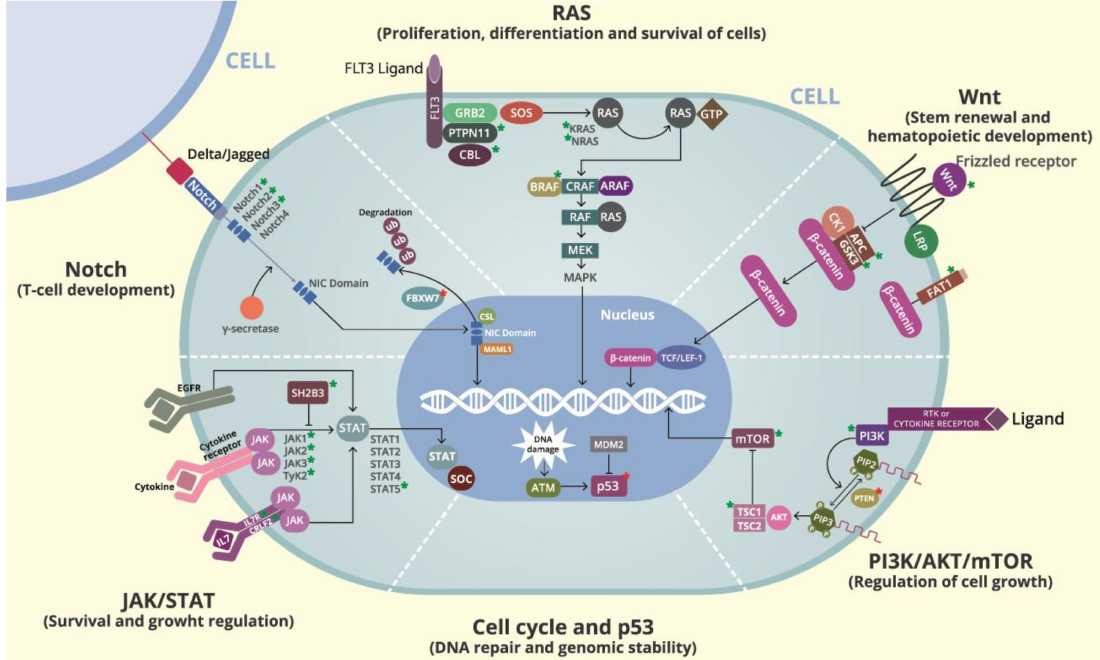
Figure 1. Cellular pathways affected by genes significantly mutated in ALL. Asterisks show the genes that are mutated in each cellular program and the biological effect of these mutations on the pathway (Green: activation mutation; Red: inactivating